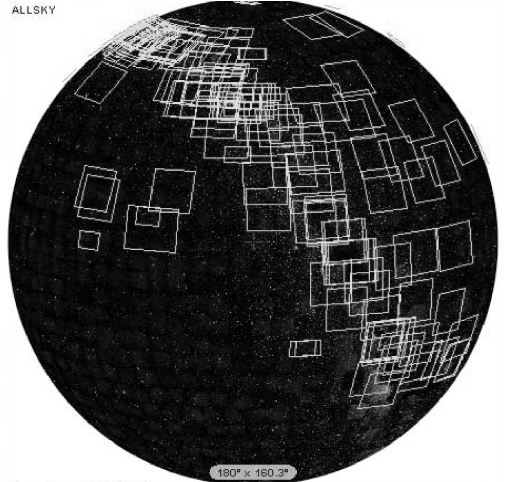
Fig. 1. The distribution of plates taken in the frame of the \G. A. Shajn Plan" in 1947{1965 on the celestial sphere. on the celestial sphere in the circumpolar region. For its solution and for further astrometric calibration, data on the coordinates of plate corners was applied. The distribution of the plates obtained in the frame of the “G. A. Shajn Plan” is shown in Figure